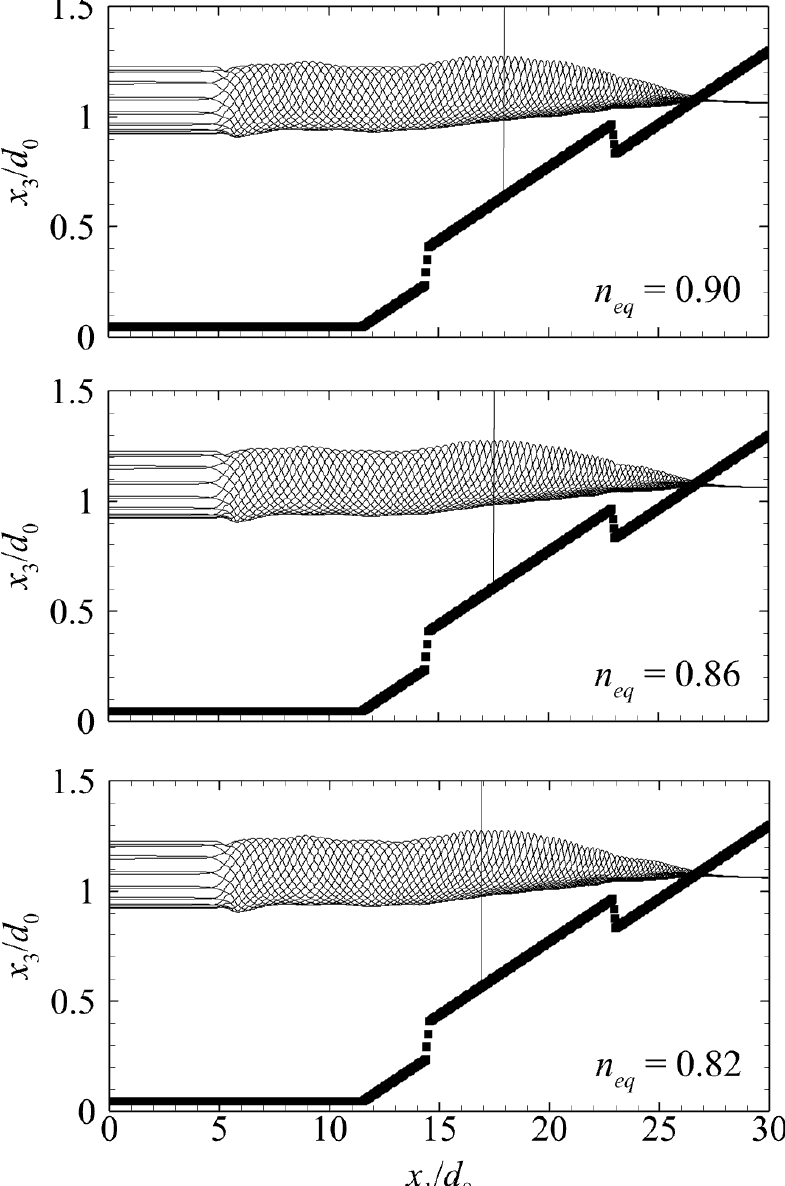
Figure 8. Phase ‐ averaged 2DV envelope of the free ‐ surface elevation of waves propagating and Figure 8. Phase-averaged 2DV envelope of the free-surface elevation of waves propagating and breaking for Cases 3 (top) to 5 (bottom). Note that the axes are in scale x 1 / x 3 = 0.1 for clarity of the breaking for Cases 3 ( top ) to 5 ( bottom ). Note that the axes are in scale x 1 / x 3 = 0.1 for clarity of exposition. the Table 2. Wave breaking streamwise position, height and depth for all simulated cases.